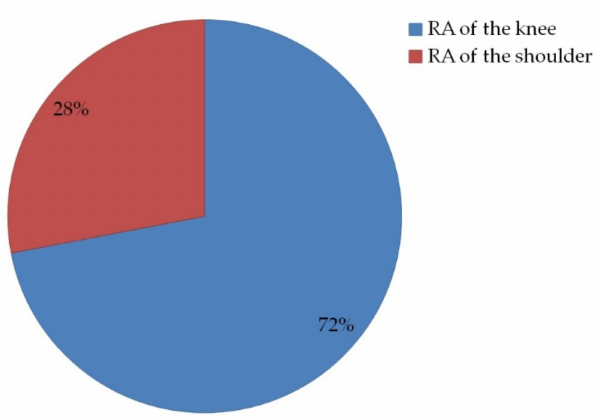
Figure 7. The distribution of rheumatoid arthritis (RA) diseases according to diagnosis. Thirty-six patients (72%) were diagnosed with rheumatoid arthritis of the knee, and 14 patients (28%) with rheumatoid arthritis of the shoulder.